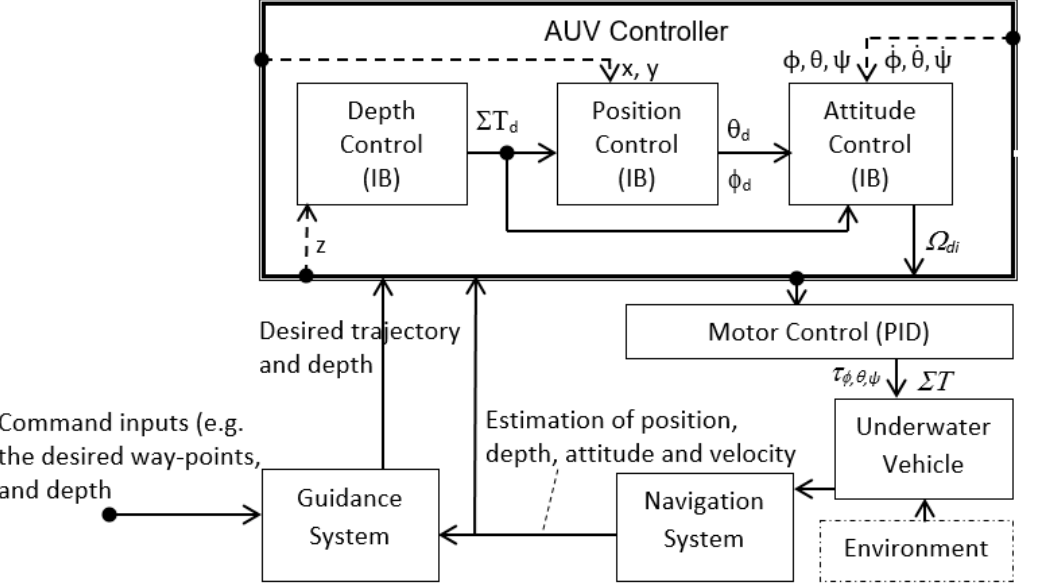
Figure 4. Functional block diagram for implementing the continuous evolution of an AUV controller.